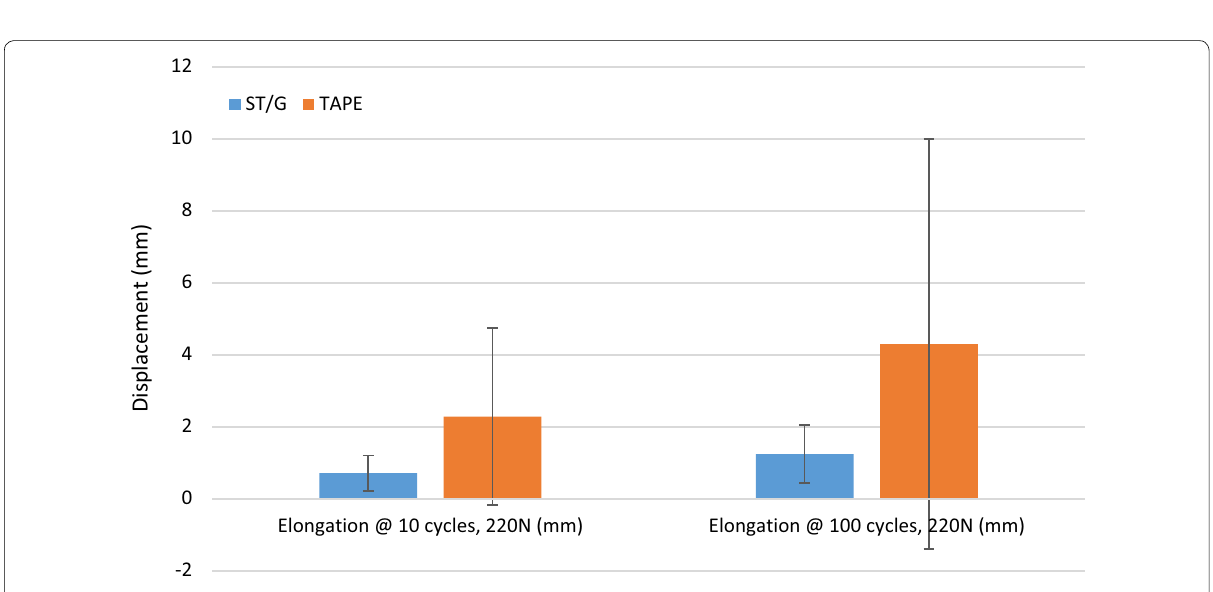
Fig. 9 Tibial fixation elongation measured at 10 and 100